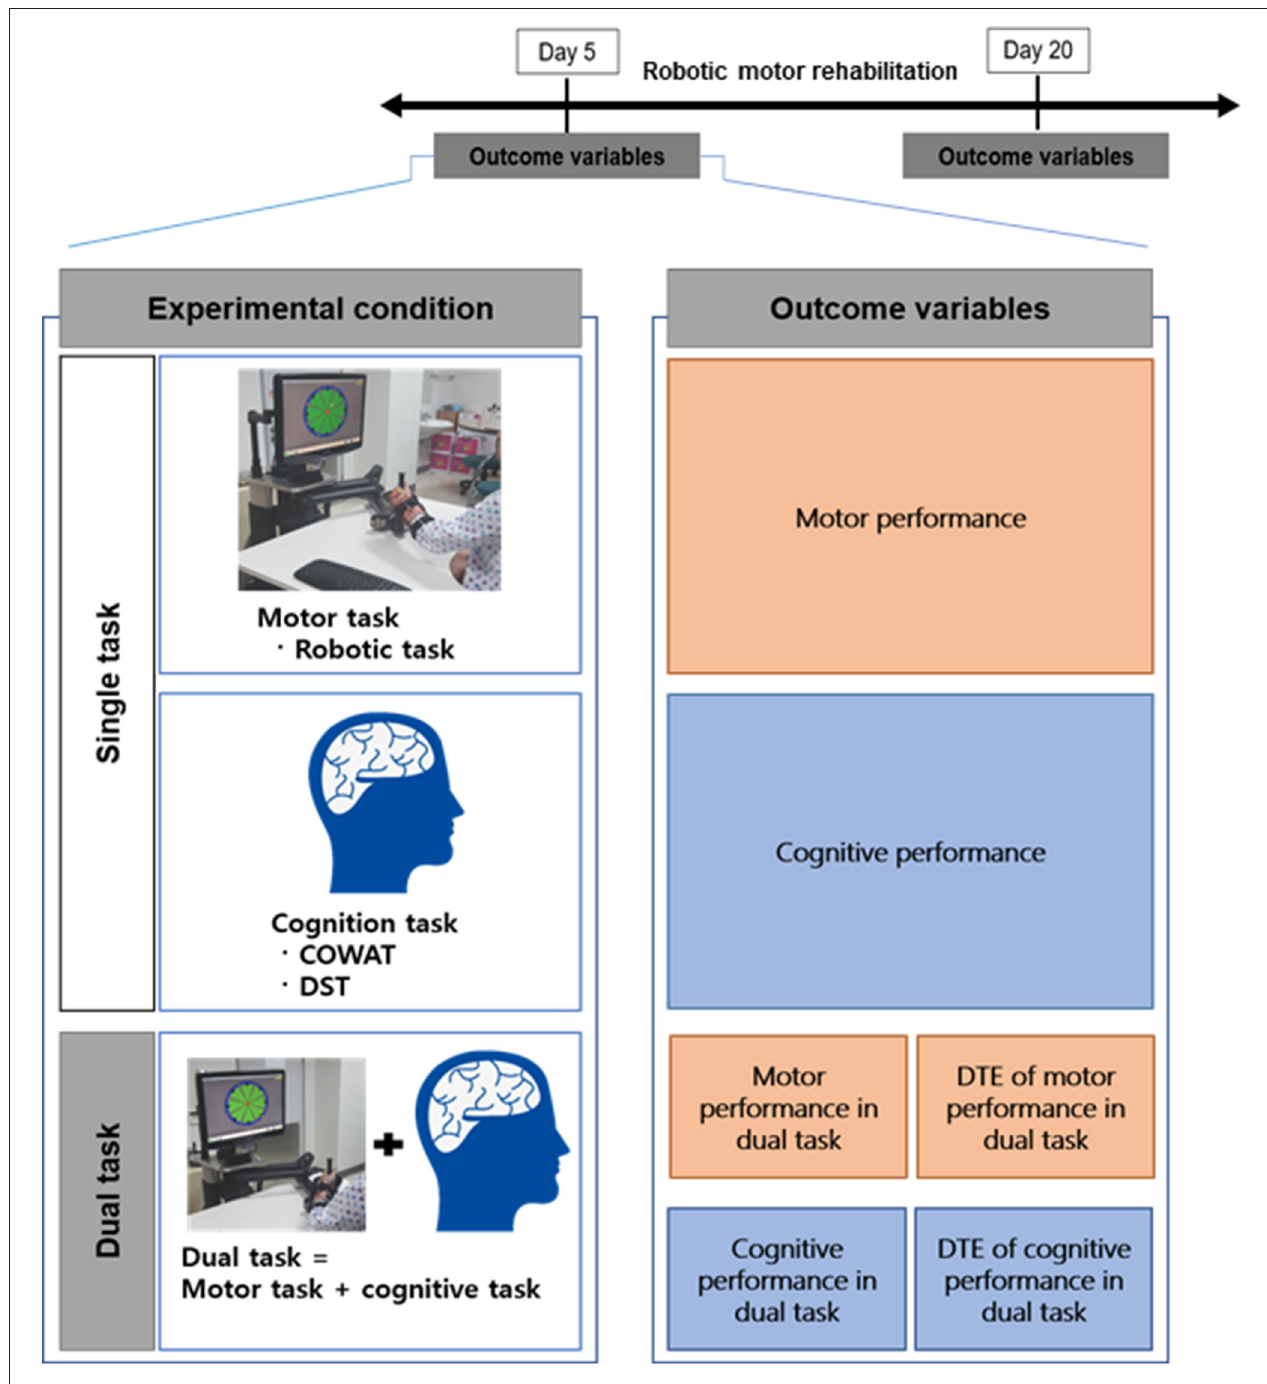
FIGURE 1 | Schematic diagram of the research methodology used. Schematic diagram of the research hypothesis on capacity changes according to motor and cognitive performance. COWAT dual performance and motor performance improved from day 5 to day 20, but not for DTE. DST dual performance did not change from day 5 to day 20, only motor performance improved, but DTE did not